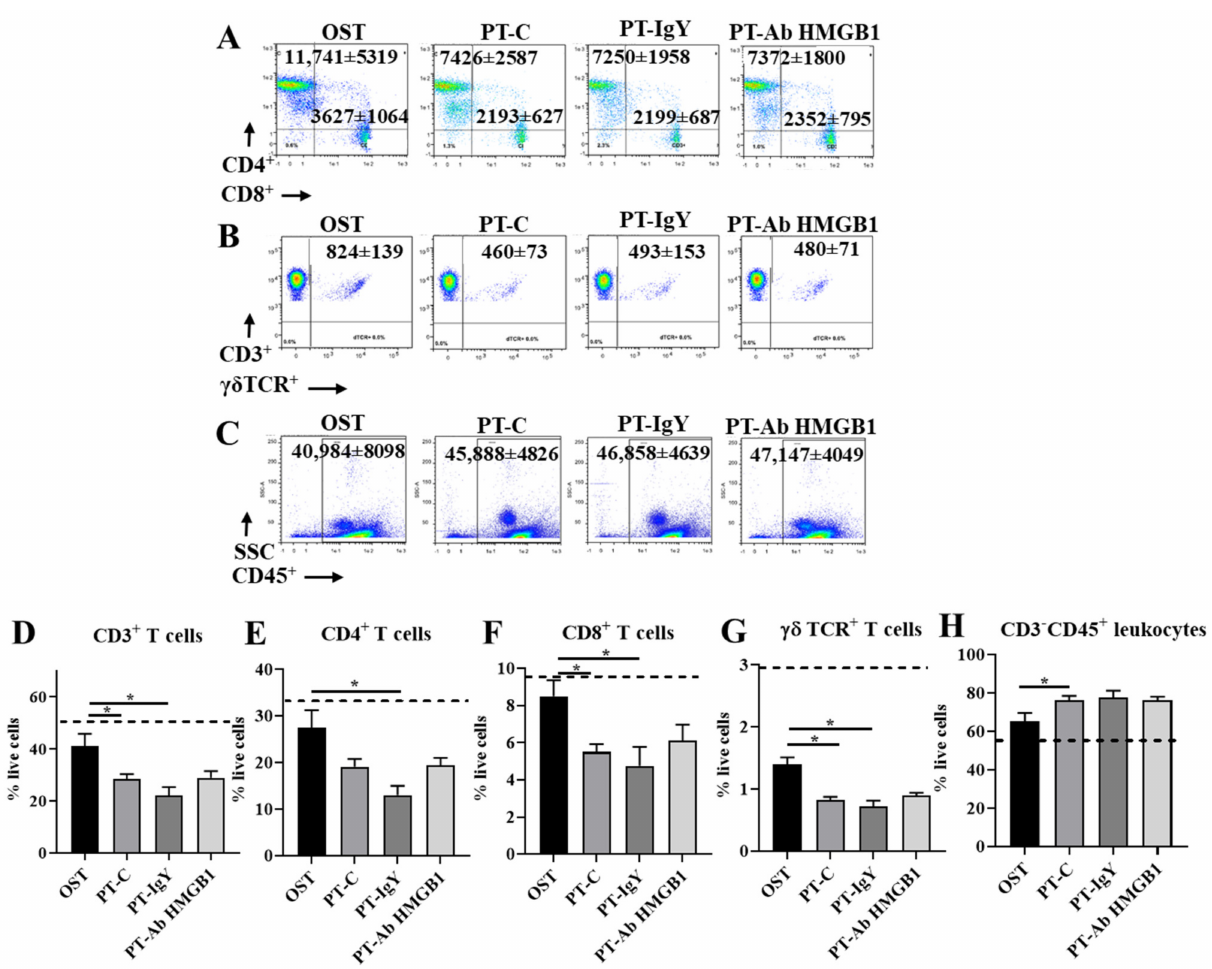
Figure 6. Flow cytometry representative dot plots with mean cell counts ± standard deviation for ( A ) CD3 + CD4 + and CD3 + CD8 + T cells; ( B ) CD3 + γδ TCR + T cell counts; ( C ) CD3 − CD45 + leukocytes in blood at 1, 3 and 7 days post-trauma (dpt) in osteotomy (OST; n = 10), polytrauma (PT-C; n = 10), polytrauma + IgY (PT-IgY; n = 5 for 1 and 3 dpt; n = 4 for 7 dpt) and polytrauma + anti-HMGB1 antibody (PT-Ab HMGB1; n = 10) rats; ( D ) percentage (%) CD3 + T cells; ( E ) % CD3 + CD4 + T cells; ( F ) % CD3 + CD8 + T cells; ( G ) % CD3 + γδ TCR T cells; and ( H ) % CD3 − CD45 + leukocytes in blood from rats with OST, PT-C, PT-IgY and PT-Ab HMGB1 at 1, 3 and 7 dpt. Naïve uninjured rats were used as baseline controls ( n = 5). The dotted line is the mean of cell counts from naïve rats. * p < 0.05 comparing OST, PT-C, PT-IgY and PT-Ab HMGB1 cohorts. The bar graphs represent mean, whereas error bars represent